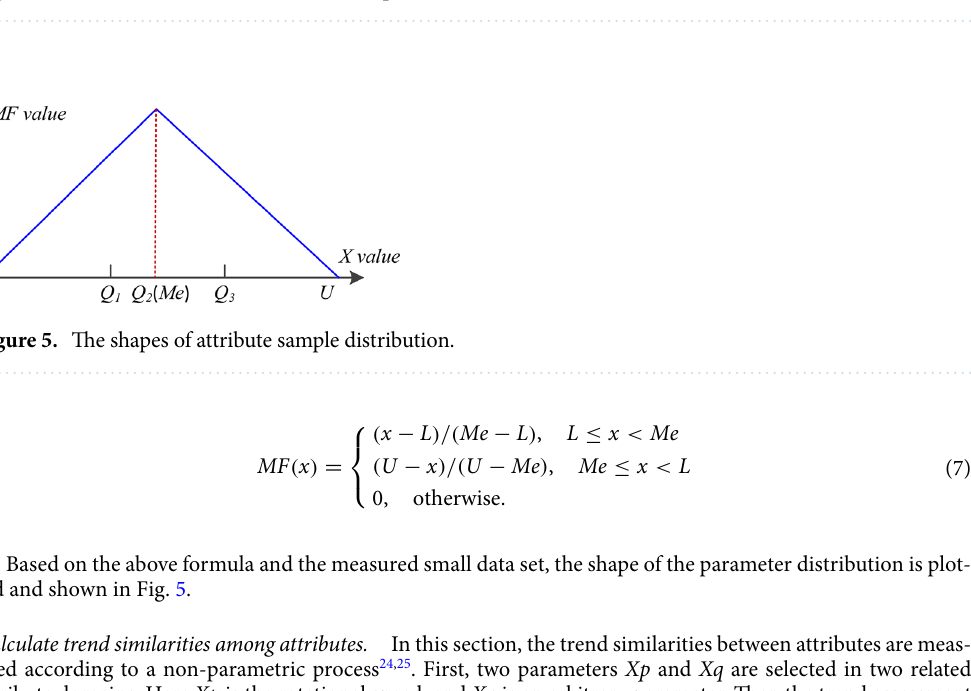
Figure 4. The flowchart of DNN method coupled with VSG.